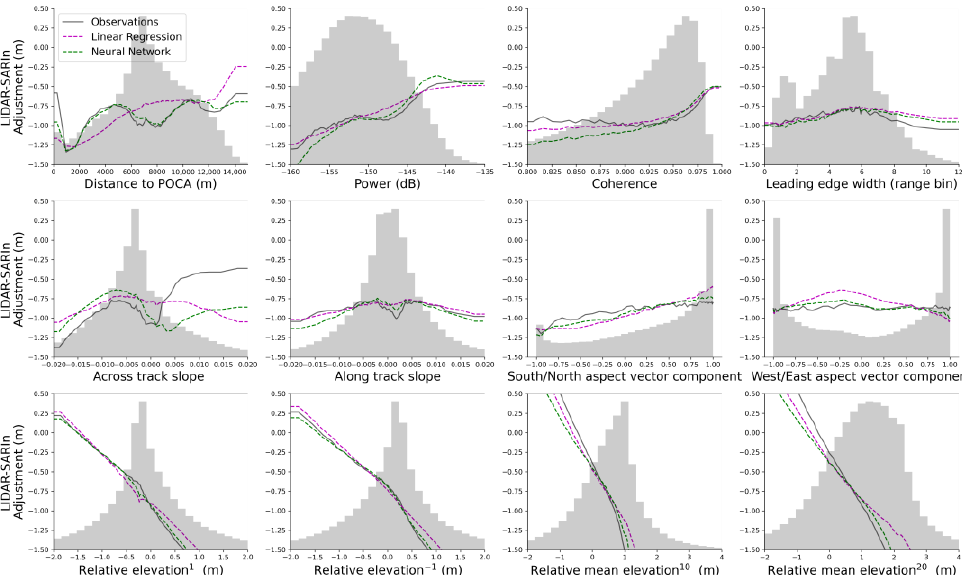
Figure 2. Summary of the observed and modelled LIDAR-SARIn differences as a function of a selection of input parameters for all 3.6 million unseen test data points across GrIS. The distribution of observation counts per parameter is shown in the grey histogram for each plot.